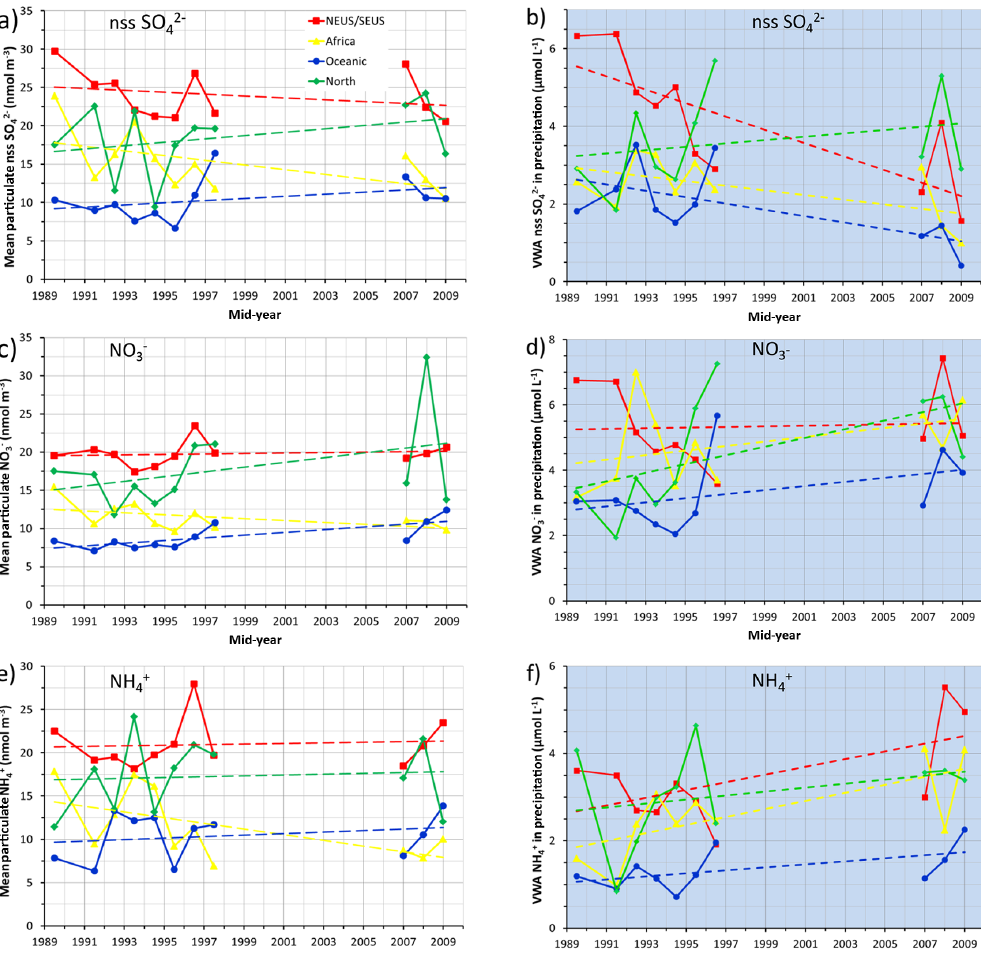
Figure 2. Temporal trends in annual average concentrations of bulk particulate (a) nss SO 2 − (white backgrounds) and annual VWA concentrations of (b) nss SO 2 − associated with NEUS/SEUS (red), African (yellow), Oceanic (blue), and North (green) flow regimes. Color-coded dashed lines correspond to SLRs for annual mean and VWA concentrations versus